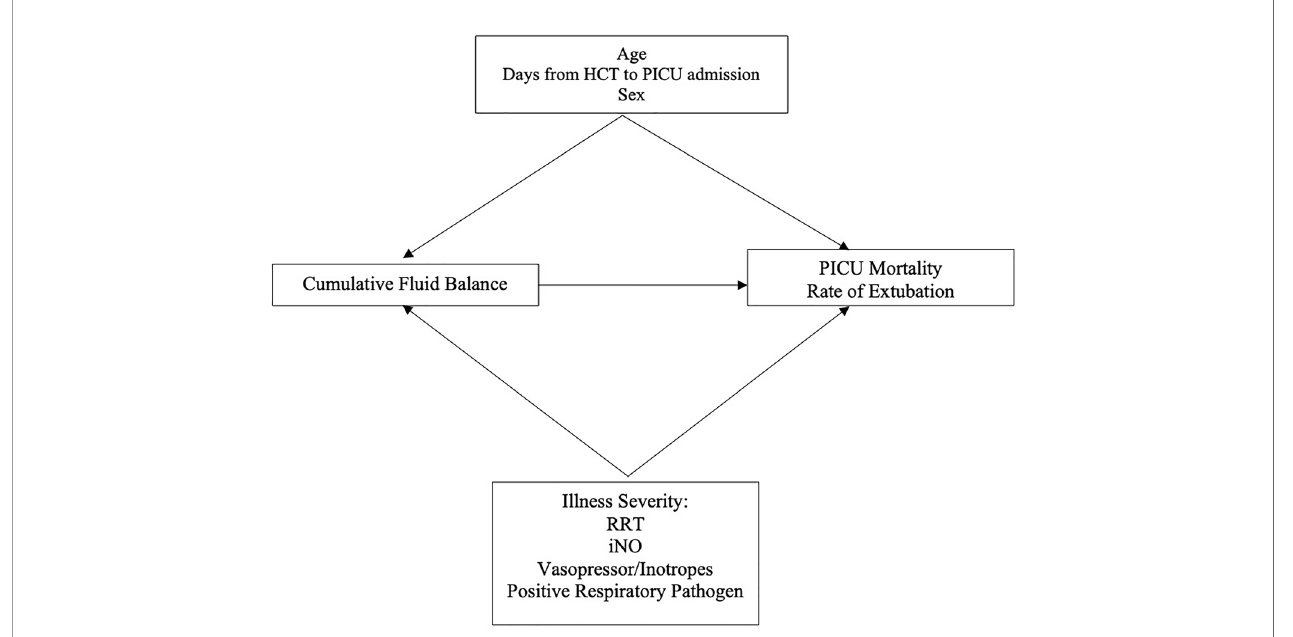
FIGURE 2 | Directed Acyclic Graph. HCT, Hematopoietic Cell Transplant; RRT, Renal Replacement Therapy; iNO, Inhaled Nitric